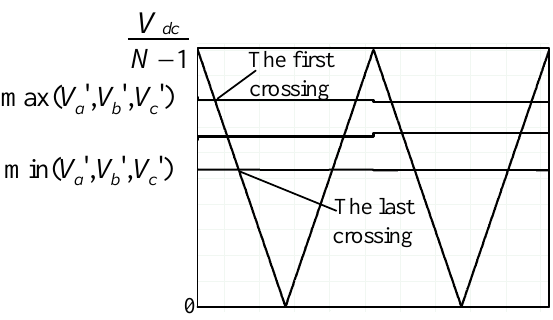
Figure 5. The common carrier and the new references V (cid:48) a , V (cid:48)